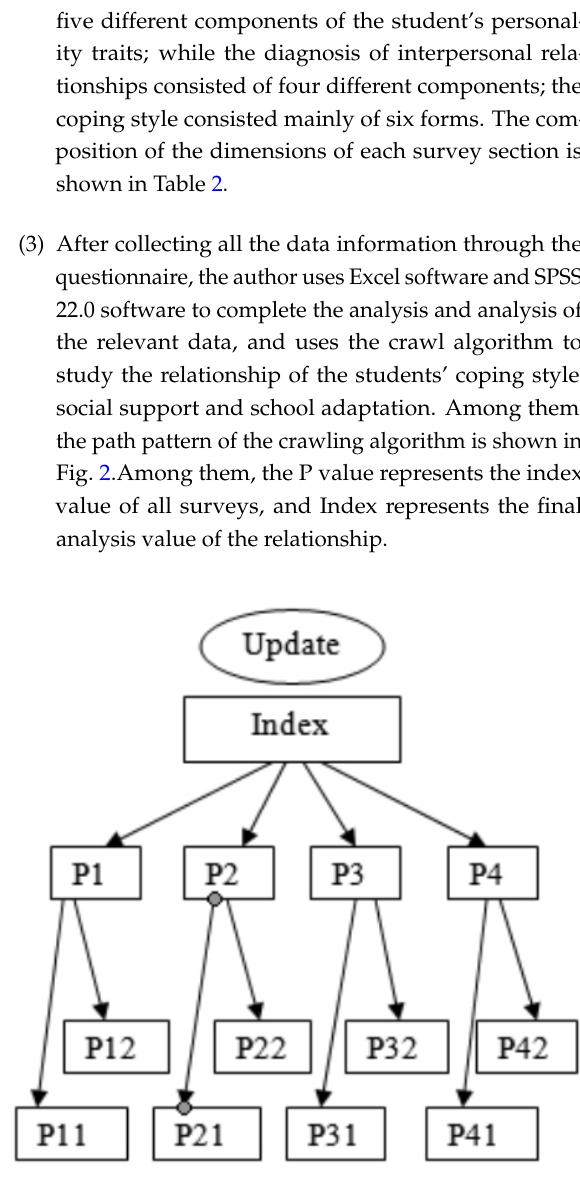
Fig. 2. Crawl algorithm mode path